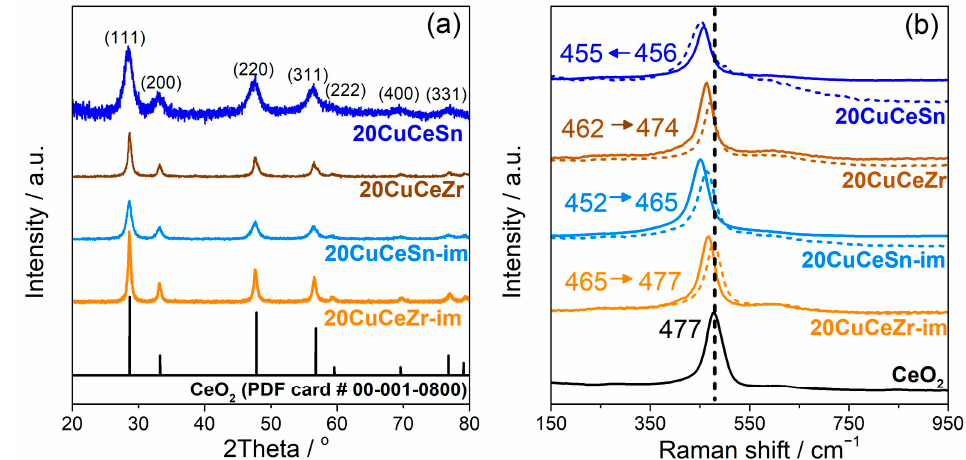
Figure 3. XRD patterns ( a ) and Raman spectra ( b ) of 20CuCeSn, 20CuCeZr, 20CuCeSn-im and 20CuCeZr-im catalysts before (solid lines) and after catalytic tests (dashed lines).